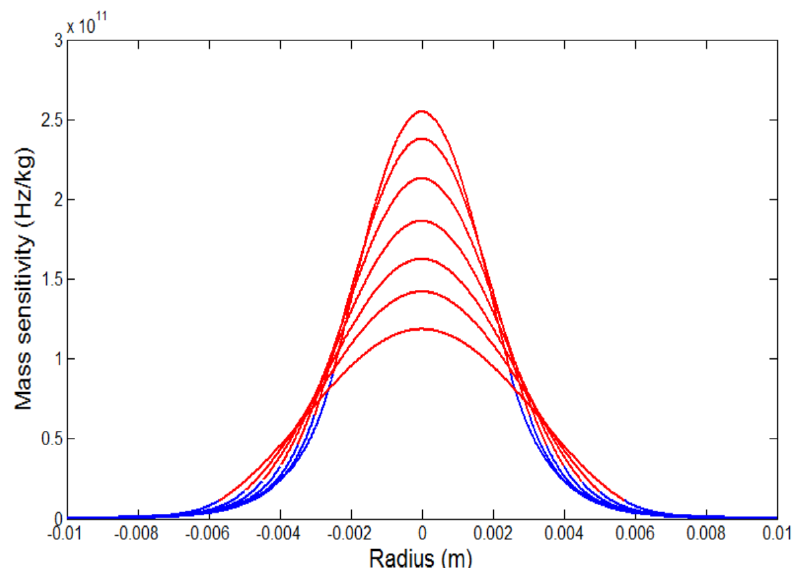
Figure 1. Mass-sensitivity distribution profiles for AT-cut 5MHz QCMs with different-sized electrodes. From top to bottom in the figure the radiuses of the electrodes are, in order, 2.5, 3, 3.5, 4, 4.5, 5, and 5.7 mm. Red line represents the electrode region and blue line represents the non-electrode region.